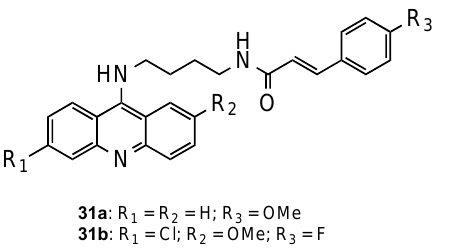
Figure 20. Acridine – cinnamic acid conjugates 31 development by Gomes and co-workers [46,47]. Figure 20. Acridine–cinnamic acid conjugates 31 development by Gomes and co-workers [46,47].